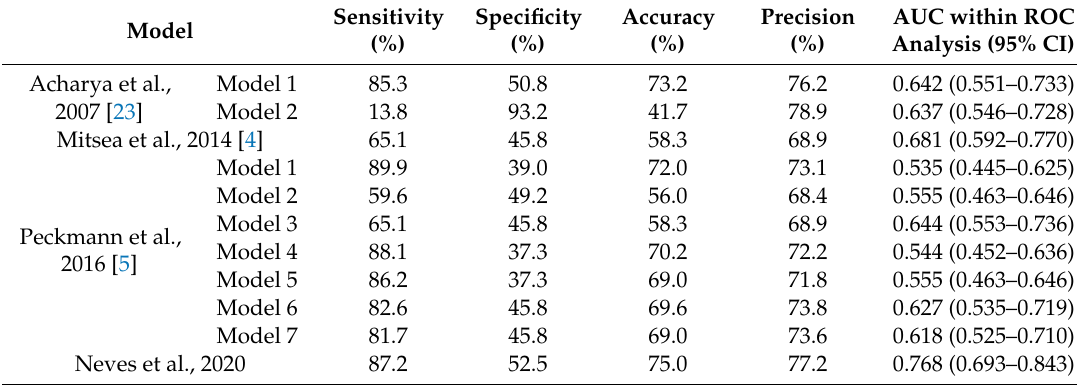
Table 3. Performance assessment of the di ff erent models when applied to the studied sample. Measures are presented as percentage. For AUC, estimation by a 95% confidence interval (95% CI) is also shown. Sensitivity Model